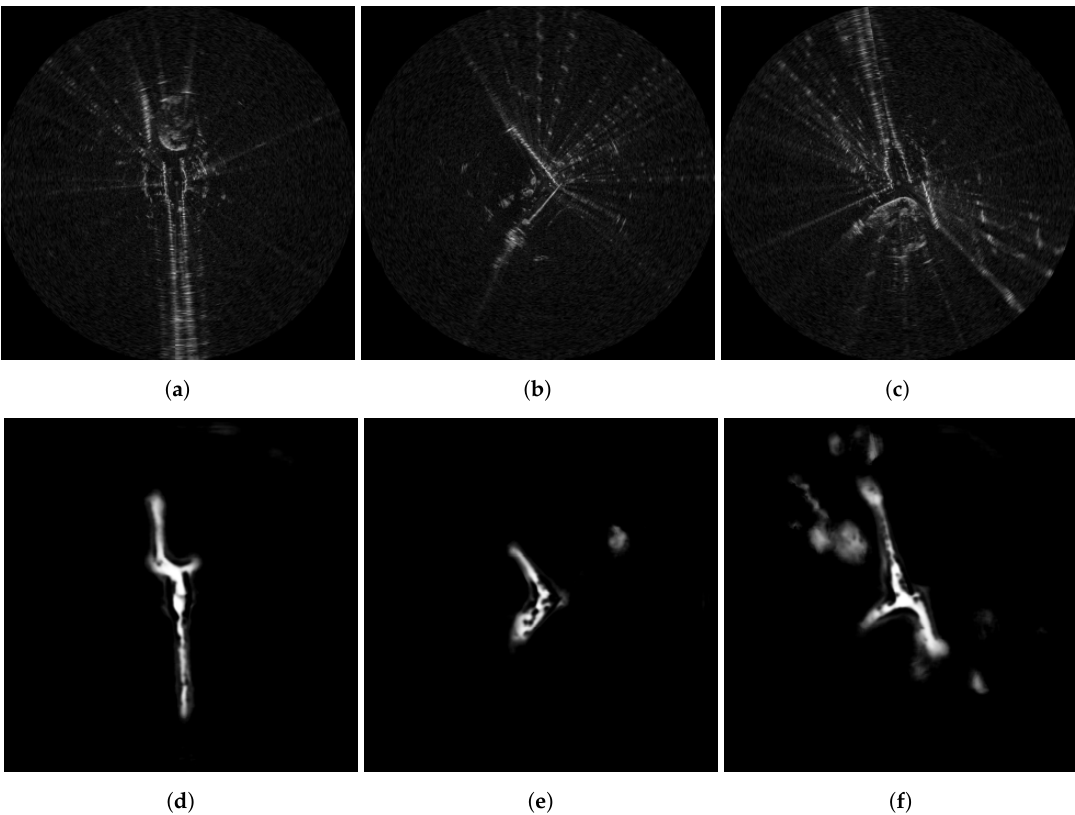
Figure 15. Traversability predictions for radar scans in a challenging urban environment as described in Section 6.1. These radar scans are taken in close proximity to one another, as the vehicle turns in a tight circle. Large areas of the radar scans are occluded by an elevated central roundabout, resulting in unusual road geometry. In ( a , d ), the vehicle approaches the turn. Here, the urban canyon behind the vehicle is understood by the model to be traversable, as is the way (left) into the turn. In ( b , e ), the vehicle is mid-way around the turn. Here, the road ahead and behind of the vehicle is entirely made up of turn, which is understood to be traversable. The model no longer sees the urban canyon due to the occlusion of the central feature. In ( c , f ), the vehicle is exiting the turn and reentering a straight urban canyon. Here, the model understands that the urban canyon as well as the original turn around the central feature are